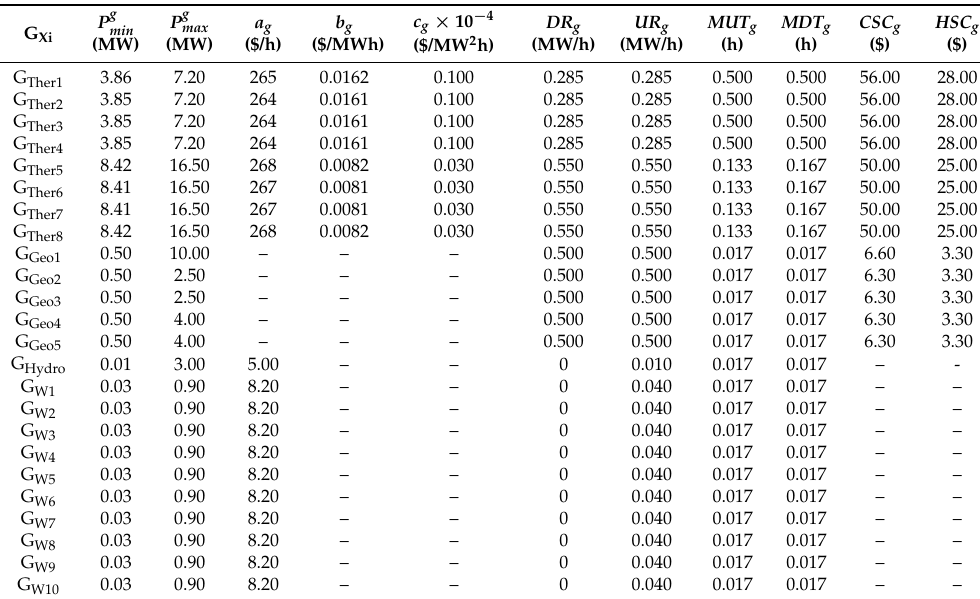
Figure 1. Main São Miguel Island power plants under study. Figure 1. Main S ã o Miguel Island power plants under study. Table 1. Main Features of the Power System under Analysis